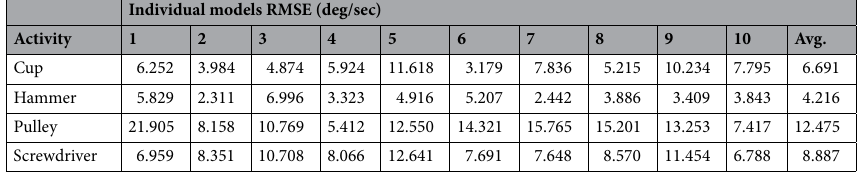
Table 2. Table summarizing RMSE values between measured ( random forest regression models trained/tested using each individual participant’s